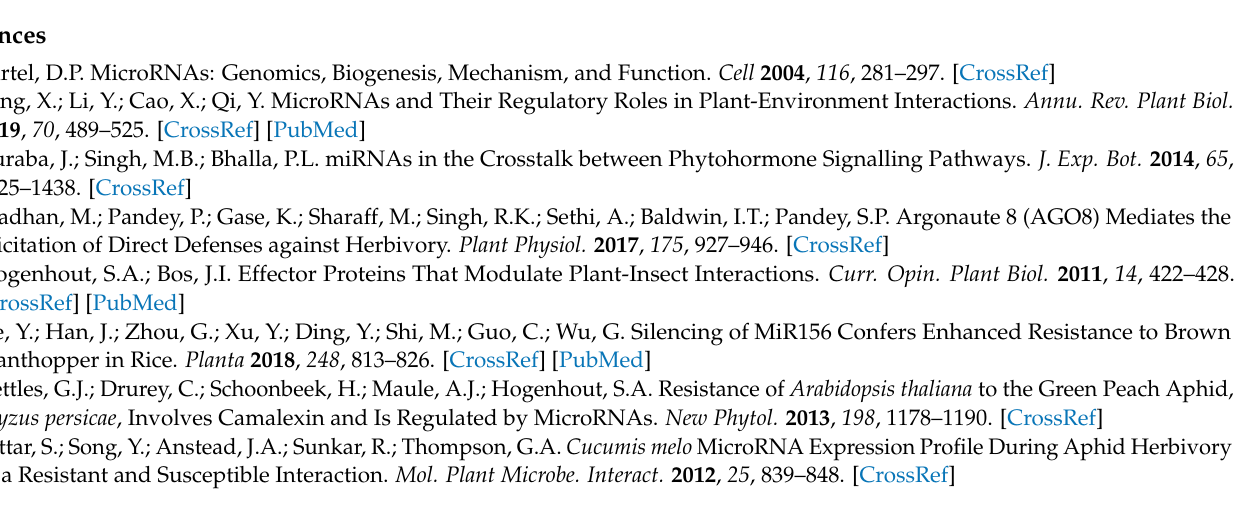
regulated miRNAs, Table S5: Summary table of significant differentially expressed miRNAs and their target genes annotation, Table S6: miRNAs classification from unique reads of degradome sequencing, Table S7: Degradome category distribution in degradome sequencing, Table S8: GO analysis of target genes in degradome sequencing, Table S9: miRNA-target modules in plant-pathogen interactions, Supplementary Data S1: Summary of known and novel miRNA in this study, Supplementary Data S2: Unique miRNAs and their target genes annotation in Control or Infested, Supplementary Data S3: All differential miRNAs, Supplementary Data S4: Degradome sequencing